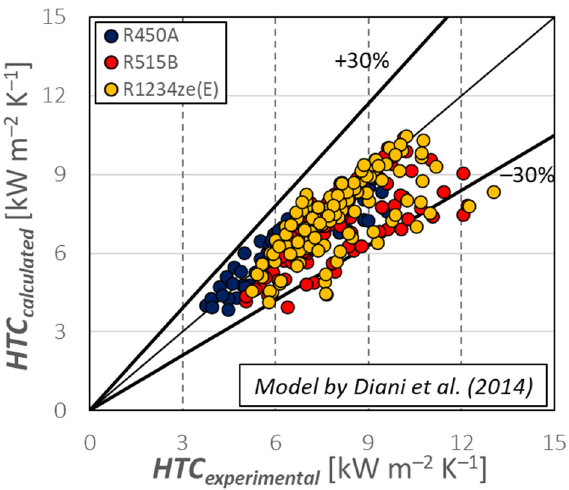
Figure 8. Calculated vs. experimental heat transfer coefficient. Model developed by Diani et al. [39]. Table 4. Accuracy of implemented correlations for heat transfer coefficient.